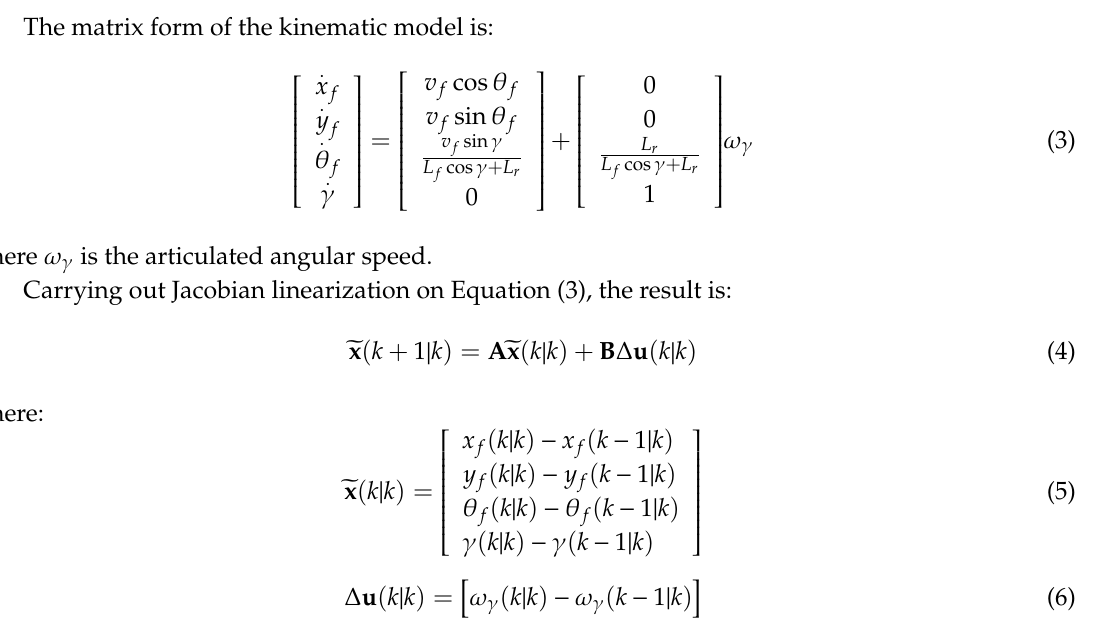
Figure 2. Model of the articulated vehicle.